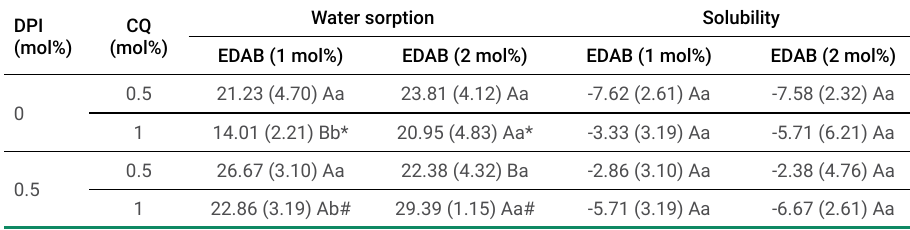
Values followed by the different upper case letter in the same column or by different lower case letter in the same row are statistically different ( p < 0.05). * and # represents statistical difference for